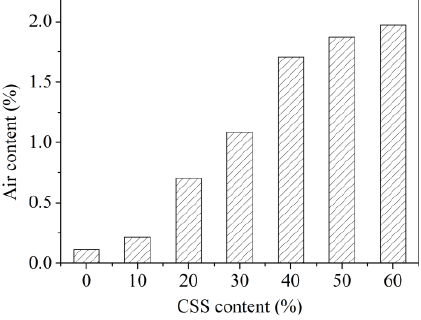
Figure 7. Air content in the pore.